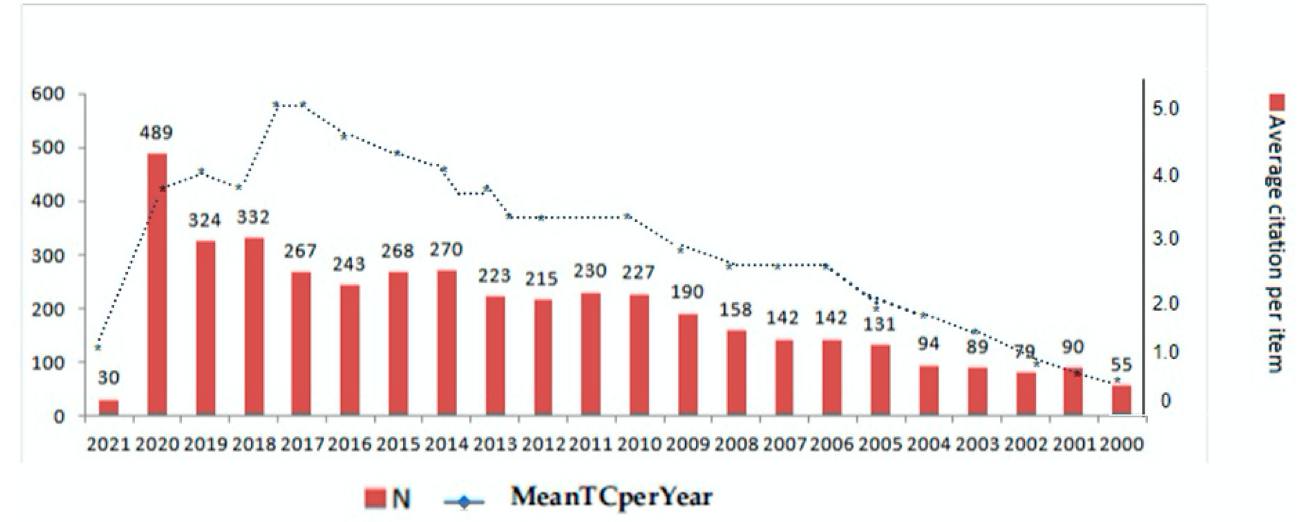
Figure 2. Published documents on VSCM from 2002–2022.